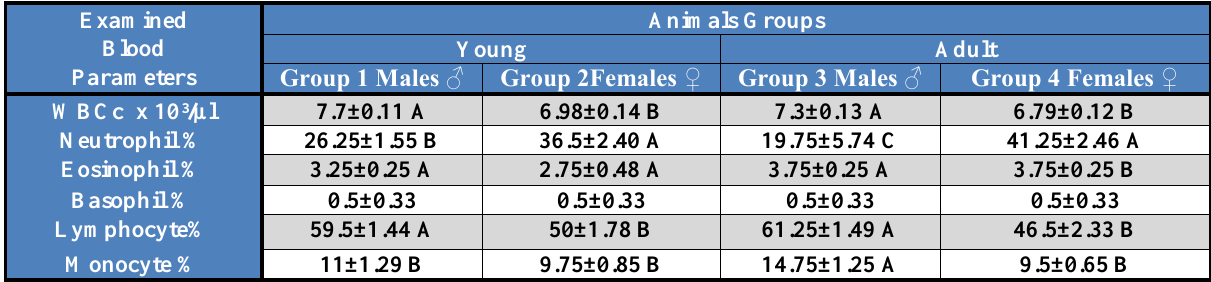
Table, 2: The results of WBCs count, Neutrophil %, Eosinophil %, Basophil %, Lymphocyte %, and Monocyte % in four groups of vervet monkeys.